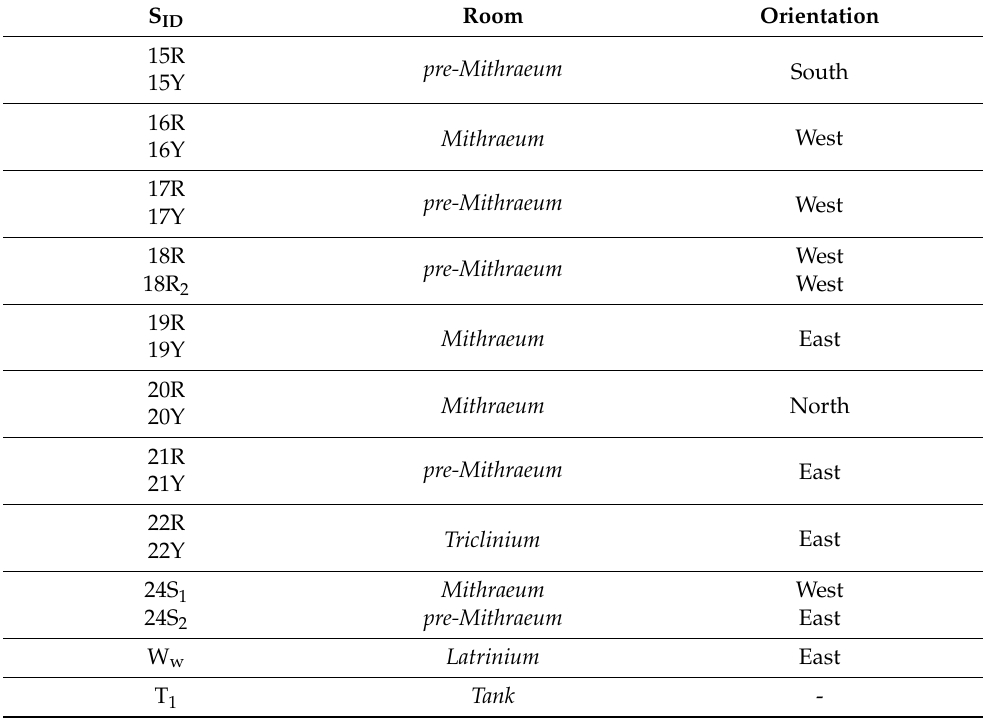
Table 1. Samples collected (name “S ID ”, room, and wall orientation). R and Y stands for red and yellow brick, respectively. W w and T 1 for well water (inside the house) and Tank (outside the house). In the case of T 1 , the sample was collected in a previous study [57]. S ID